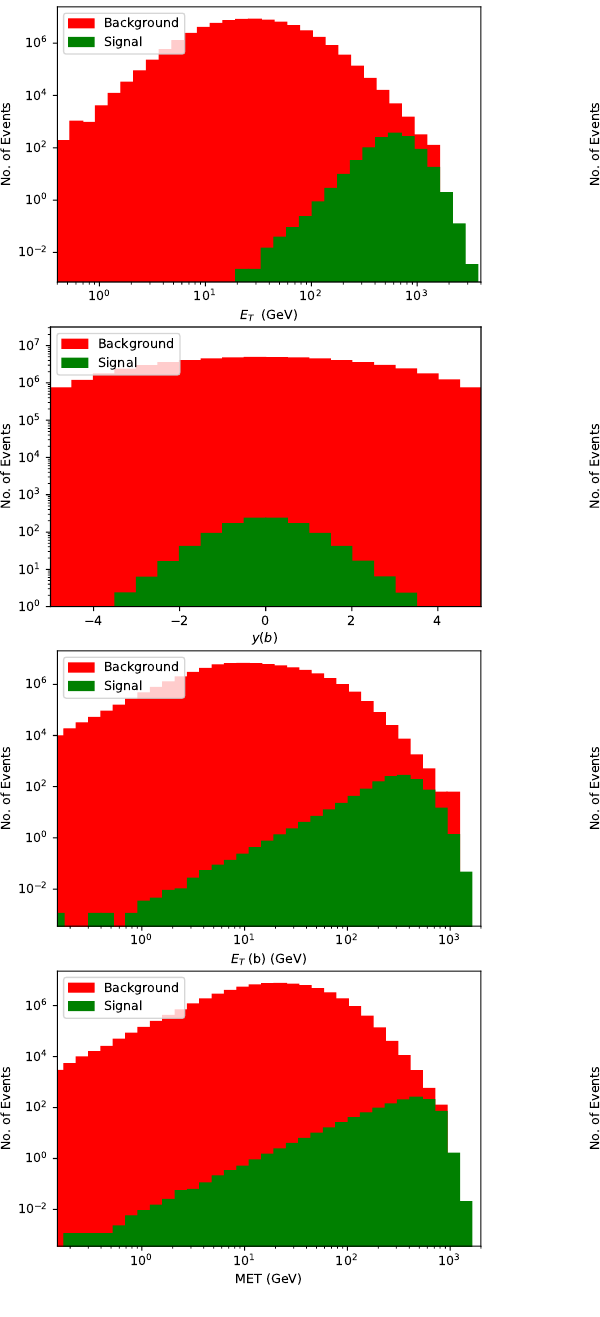
H 0 /A 0 A 0 for BP2 normalized to 1 1 1 1 , T